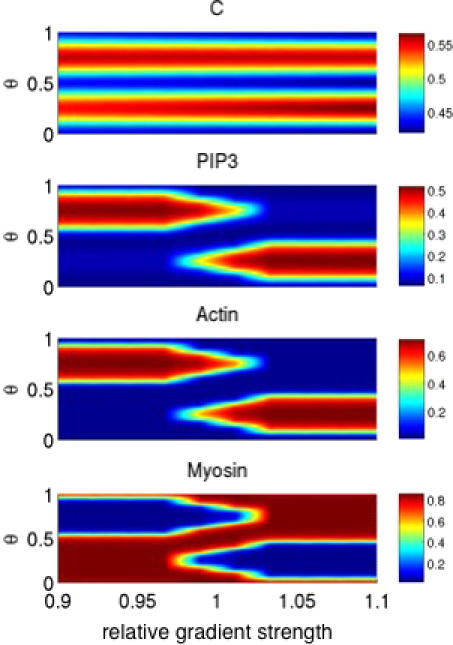
Double Micropipette ExperimentSteady-state distribution of PIP3, actin, and myosin in response to two opposing micropipettes placed equidistantly around the cell. One gradient was fixed and the second was varied in intensity. The relative strength is the ratio of the peak concentrations of the two chemoattractant sources. When the chemoattractant profiles of the micropipettes are equal (relative strength equal to one), the cell forms two fronts and two backs. When one micropipette has a significantly higher peak concentration than the other, only one front and one back forms. The nominal parameters for both gradients is bL = 1 and gL = 50%.